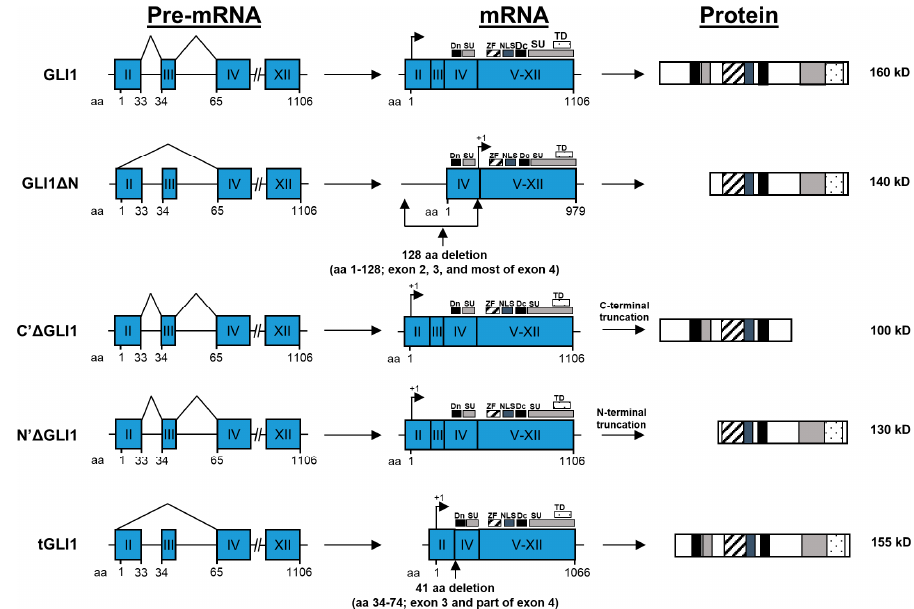
Figure 2. Structures of the GLI1 gene and known GLI1 isoforms. The full-length GLI1 gene consists of 12 exons, including the 5 ′ -untranslated exon I. The GLI1 coding region spans nt +79 to +3399 with the initiating methionine codon, ATG, at +79 in exon II (arrows). Exons are indicated as blue boxes, and introns are shown by lines. The known functional domains of full-length GLI1 include the degron degradation signals (Dn and Dc; aa 77–116; 464–469), SUFU-binding domains (SU; aa 116–125 and C-terminus), zinc-finger domains (ZF; aa 235–387), the nuclear localization signal (NLS; aa 380–420), and the transactivation domain (aa 1020–1091). Alternative splicing of GLI1 RNA can lead to the deletion